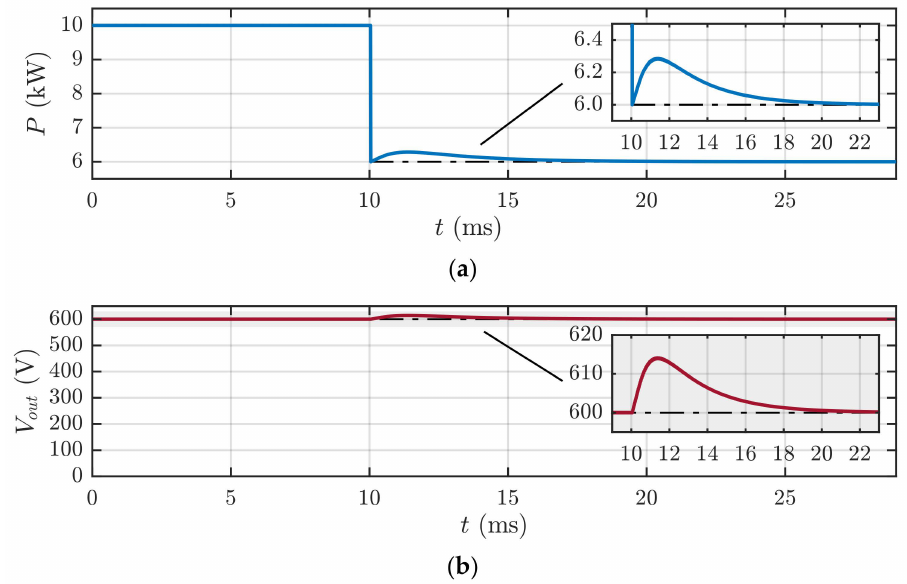
Figure 12. Output power ( a ) and output voltage ( b ) change on the DC bus when load changes from 10 kW to 6 kW with the proposed control